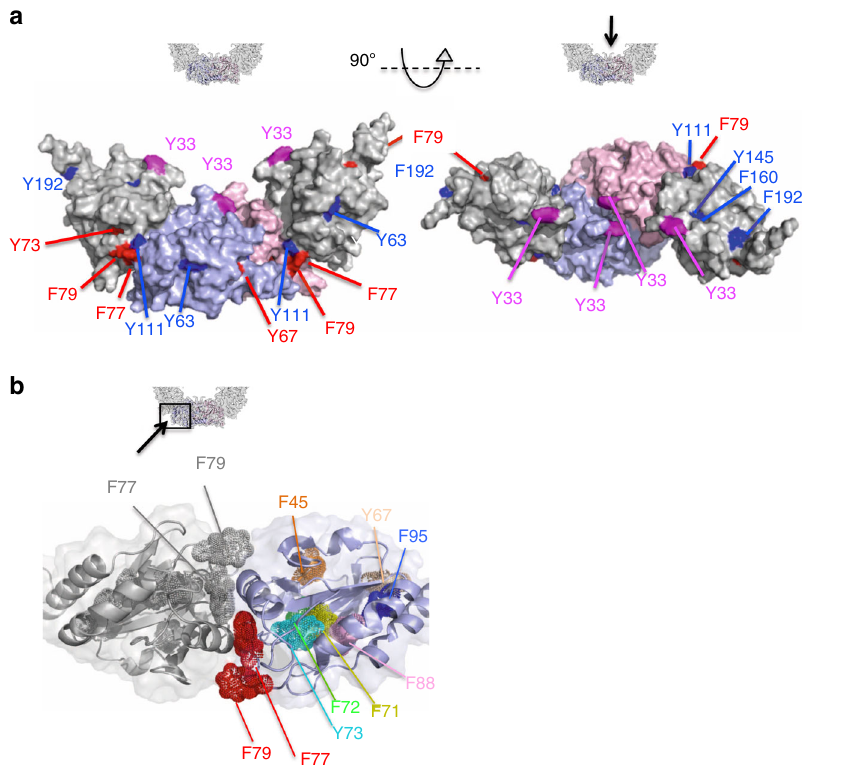
Fig. 4 Mapping of in vivo cross-linking sites onto quaternary structure of mTXNPx. a Quaternary structure of reduced L. infantum mTXNPx red . For simplicity, only one of the fi ve dimers that are present in the decamer (subunit A in pink and subunit B in blue) as well as one adjacent subunit on each side (grey) are shown. Different views of the selected mTXNPx dimer are presented. Amino acids that, when replaced by Bpa, reproducibly produce higher migrating smear upon UV-cross-linking either after shift to 45 °C (Group 1, red), at both 30 °C and 45 °C (Group 2, magenta) or no shift (Group 3, blue) are shown. b Close-up view of the dimer-dimer interface and location of Group 1 residues. Group 1 residues F77 and F79 (red and grey dots) form part of the dimer-dimer interface. All other group 1 residues (in rainbow colors) are mostly